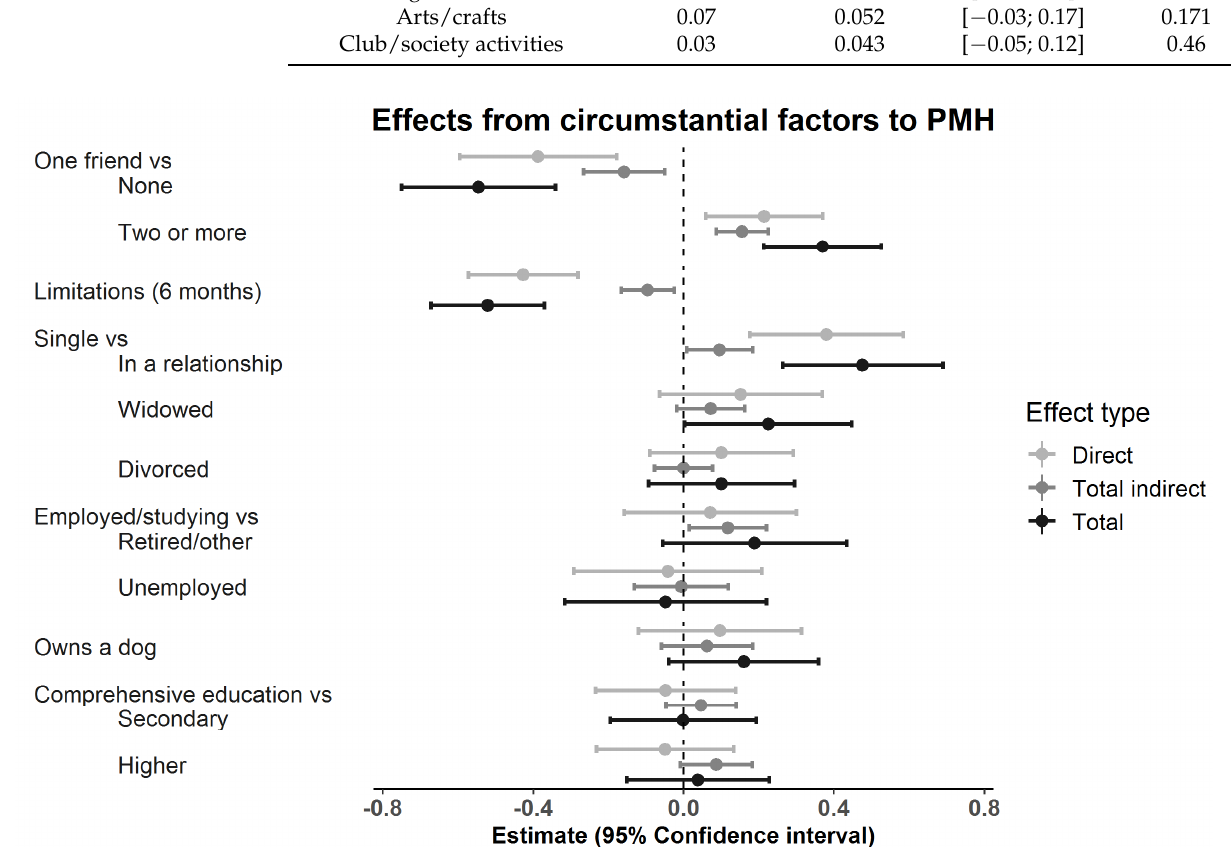
Figure 2. Illustration of the main reported structural equation model ( n = 801) where positive mental health is specified as a latent factor whose loadings (reflecting correlation between the factor and the items) are shown at the right side of each item. The residual correlations between the leisure-time activities and the path estimates from each situational and demo- graphic covariate to each leisure-time activity and positive mental health were estimated but they are not shown for clarity (provided in Table 2, Figure 3, and Appendix A Table A2). In bold: the 95% CI of the standardised estimate does not overlap with 0.